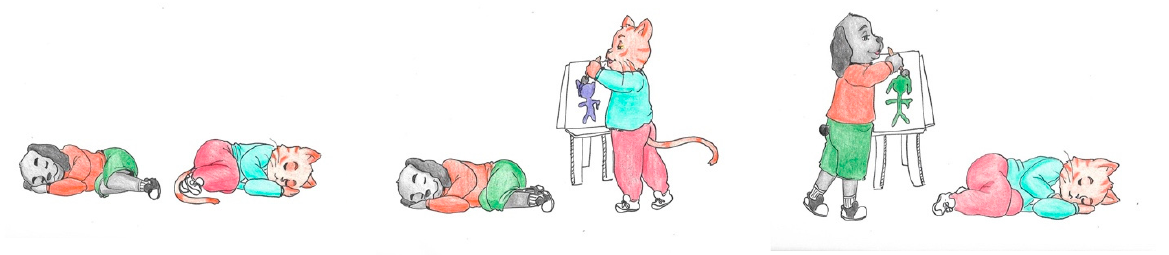
Figure A31. Filler stimulus 6.